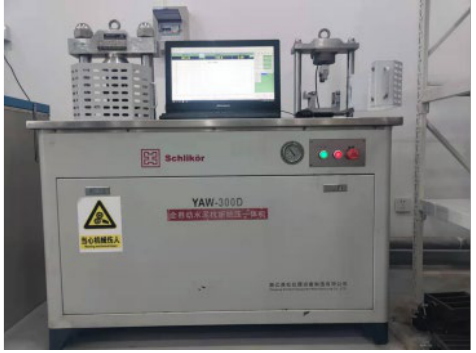
Figure 5. Fully automatic concrete flexural compressive all-in-one.